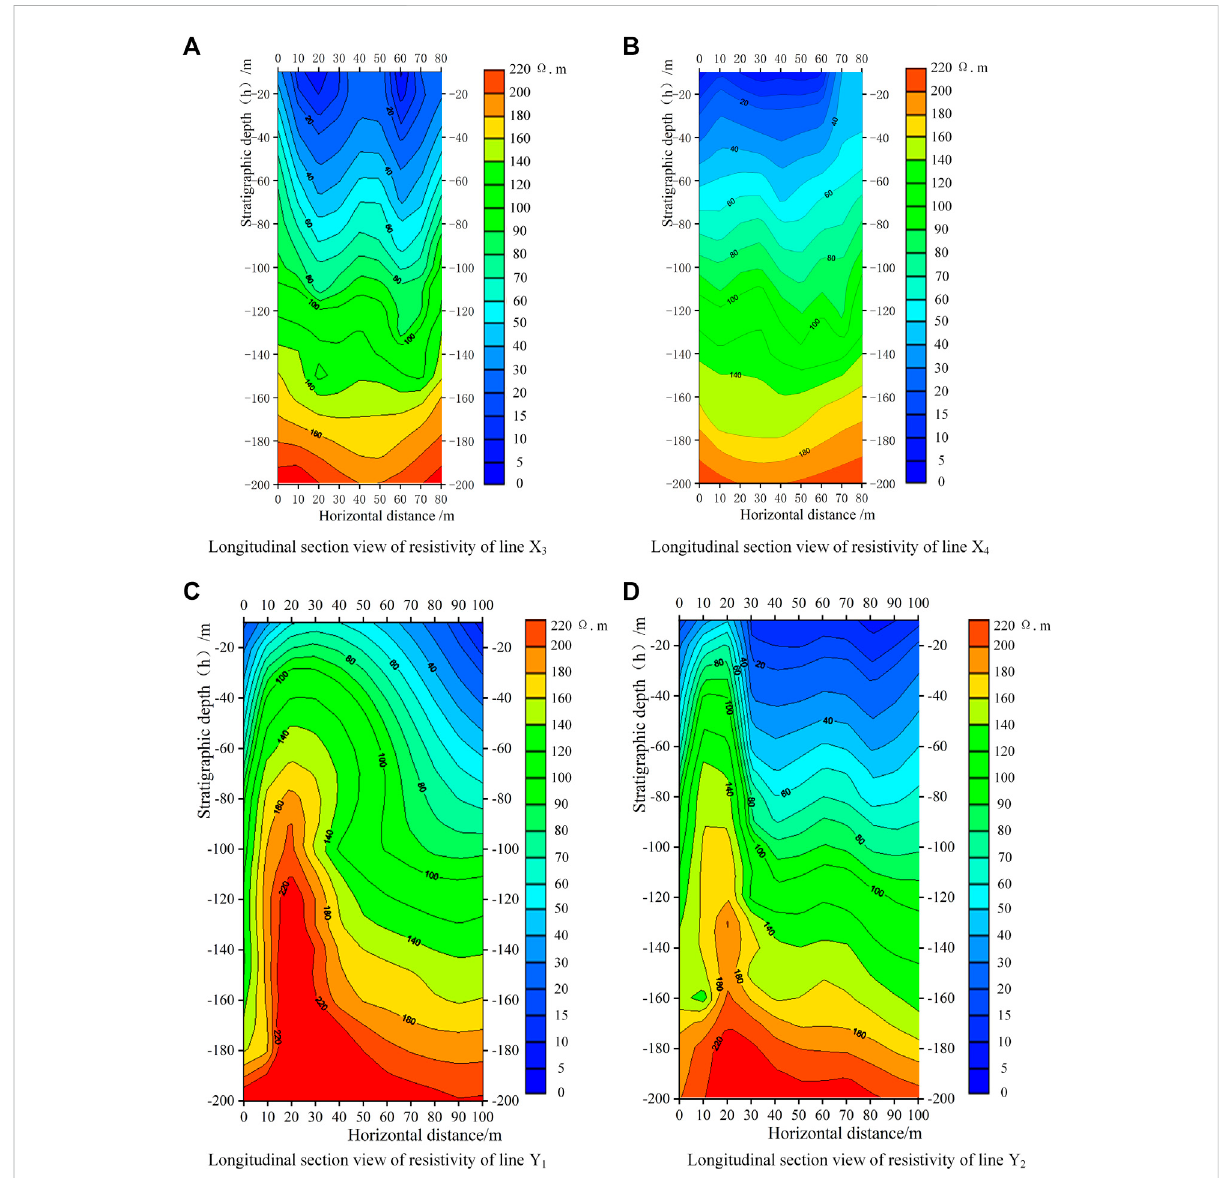
FIGURE 7 Longitudinal section view of resistivity of X 3 , X 4 , Y 1 , and Y 2